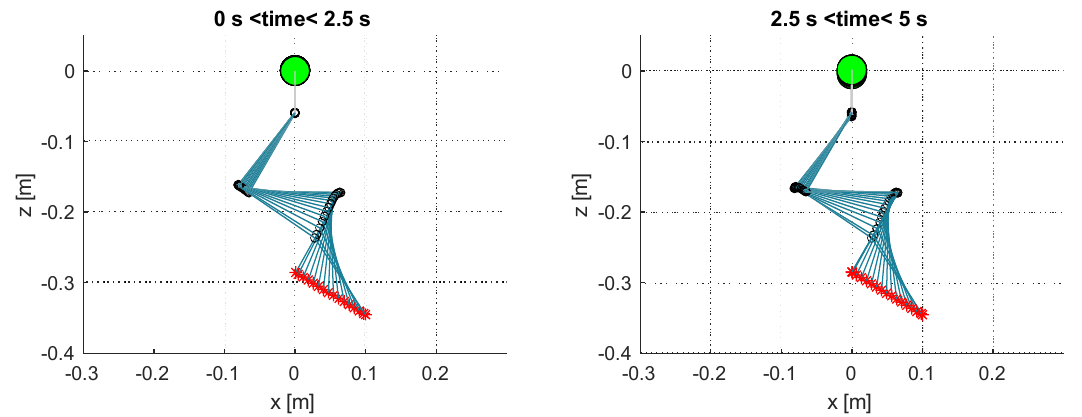
Figure 17. Stroboscopic trajectories for the first half ( left ) and second half ( right ) of the linear trajectory task for the 3-DOF redundant UAM using the extended Jacobian. The UAV base is the large green marker, joints are the black circles, links are the blue lines, and end-effector positions tracked are the red crosses.